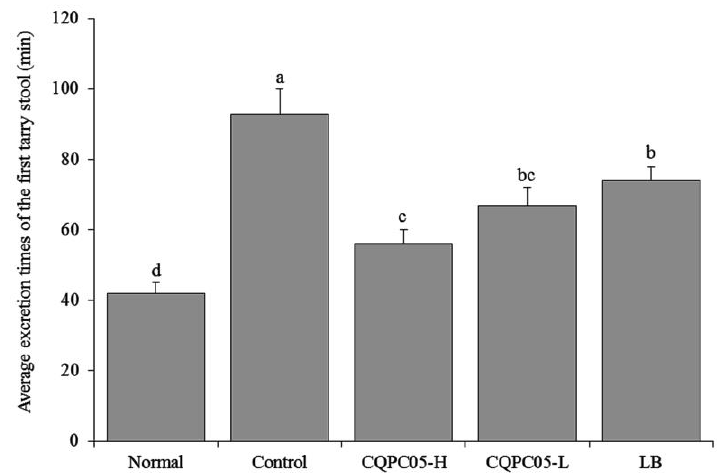
Figure 3. Average excretion times of the first tarry stool of the Lactobacillus plantarum CQPC05 and Lactobacillus delbrueckii subsp. bulgaricus treated activated carbon-induced constipation mice (average value of five mice in each group). a – d The different letters mean that there are significant differences ( p < 0.05) between every two groups according to Duncan’s multiple range test. LB: Lactobacillus delbrueckii subsp. bulgaricus (1.0 × 10 9 colony-forming unit (CFU)/kg body weight (bw)); CQPC05-L: Lactobacillus plantarum CQPC05 low dose (1.0 × 10 8 CFU/kg bw); CQPC05-H: Lactobacillus plantarum CQPC05 high dose (1.0 × 10 9 CFU/kg bw).